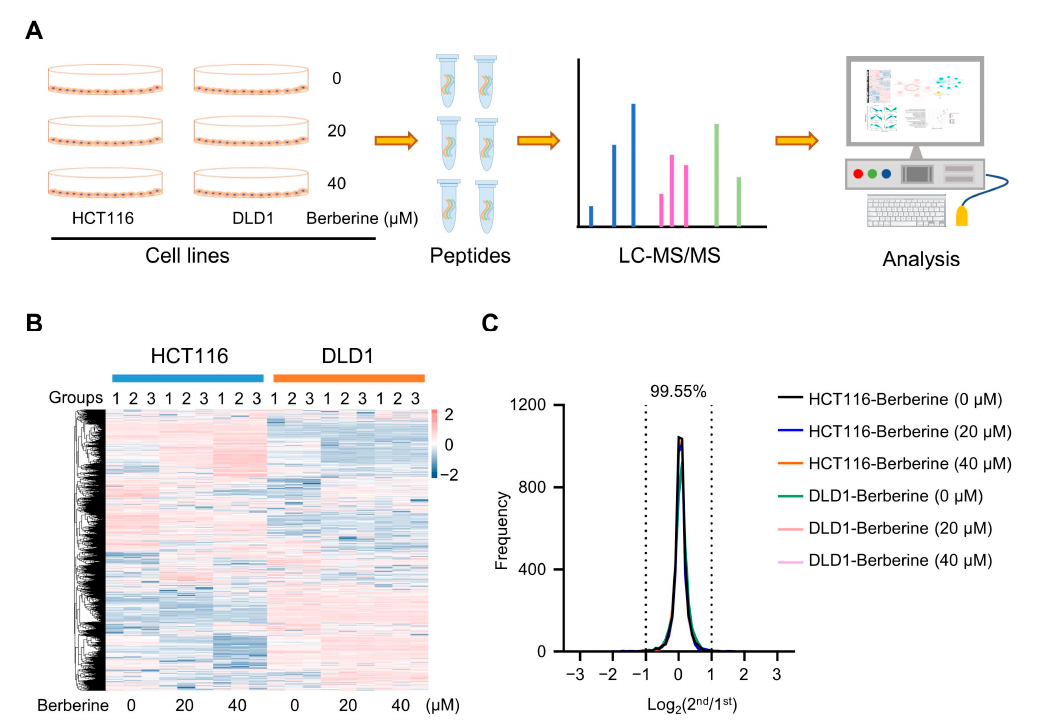
Figure 2. Proteome profiles and quantification of proteins among different berberine treatment conditions in HCT116 and DLD1 colon cancer cell lines. ( A ) Workflow of the proteomic study. Two colon cancer cell lines, HCT116 and DLD1, were separately treated with different concentrations of berberine for 48 h, and the control (0 µ M) was added with same amount of dimethyl sulfoxide. The total proteins were then extracted, trypsin-digested, and underwent triplicate LC-MS/MS runs for label-free quantitative proteomics analysis. ( B ) Heatmap of quantified proteins in HCT116 and DLD1 cells. Cells were treated with different concentrations (0 µ M, 20 µ M, 40 µ M) of berberine for 48 h. Groups indicate three technical repeats under each treatment condition; the color bar indicates the Z-score of intensities. ( C ) Ratio distributions of quantified proteins among technical replicates of each sample.